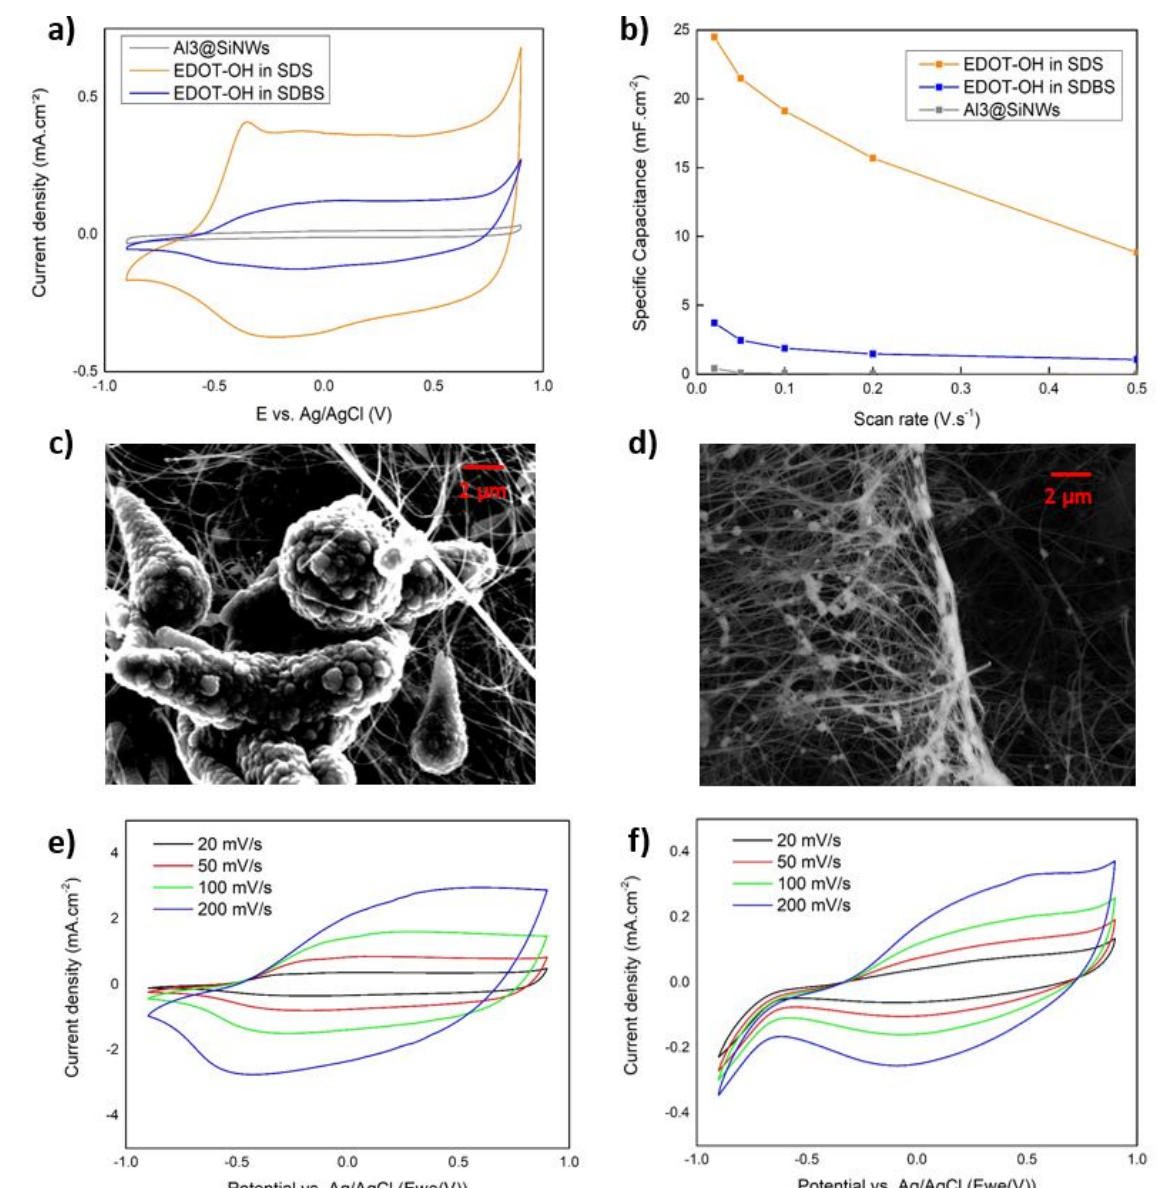
Figure 3. ( a ) Comparison between with the bare Al 3 @SiNWs of the SDS and SDBS 100 cycles electropolymerization in Na 2 SO 4 0.7 M and ( b ) their capacitance evolution regarding the scan rate. SEM images of electropolymerization made with ( c ) SDS and ( d ) SDBS in SE2. Cyclic voltammetry at different scanning rate of ( e ) EP in SDS and ( f ) EP in SDBS.